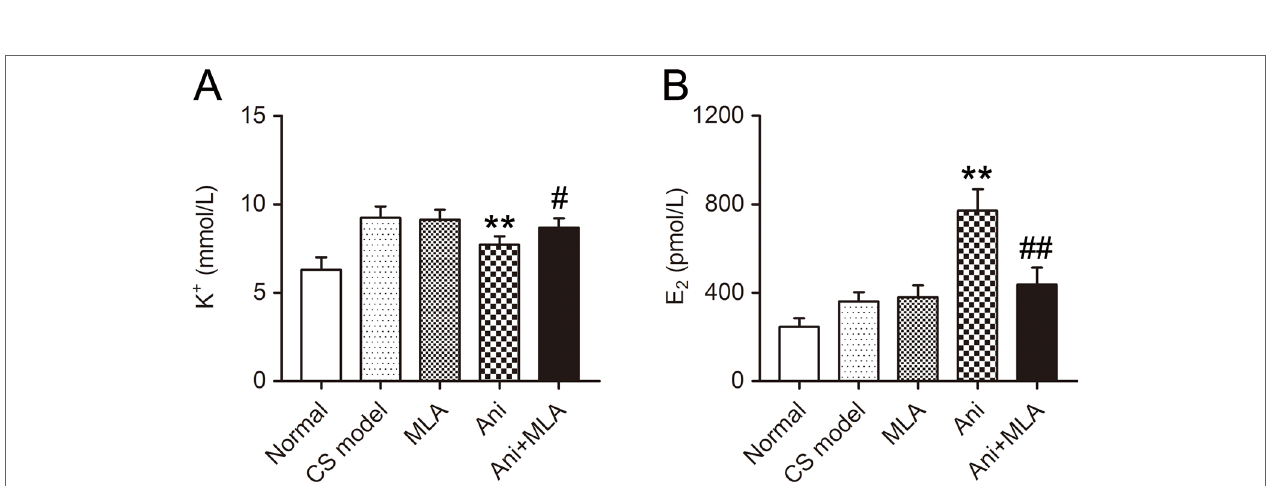
FIgURE 2 | Anisodamine (Ani) decreases serum K + and increases serum E 2 in male mice with crush syndrome (CS). Ani (28 mg/kg, i.p.) was administrated at 30 min before decompression in mice with CS, and methyllycaconitine (MLA) (10 mg/kg, i.p.) was given 30 min earlier. Blood samples were collected at 6 h after decompression. Ani decreased serum K + level after decompression, and MLA significantly counteracted such effect of Ani (A) . Ani increased serum E 2 level after decompression, and MLA significantly counteracted such effect of Ani (B) . N = 6 per group. ** P < 0.01 vs. CS model. # P < 0.05, ## P < 0.01 vs.